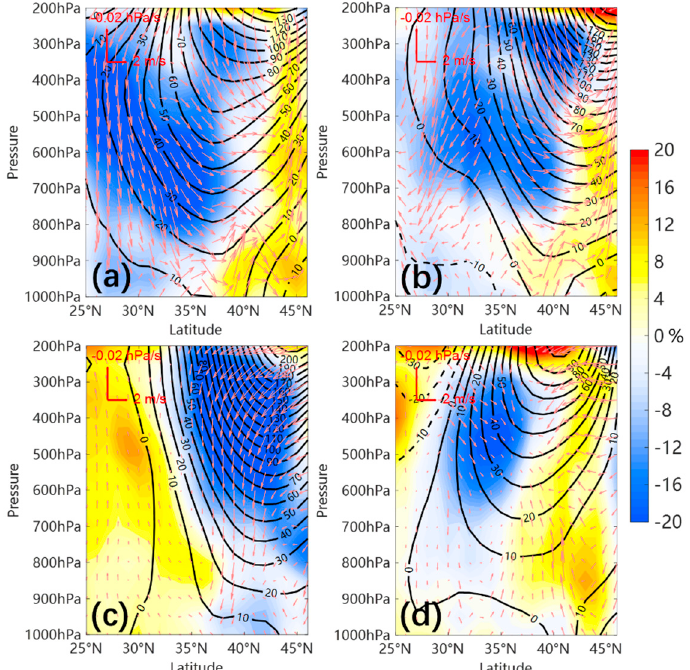
Figure 6. Zonally averaged geopotential height anomalies (contours; interval = 10; units: gpm), relative humidity anomalies (shading; units: %) and v-omega anomalies (vectors; units are labelled in the figure) over region B from the land surface to 200 hPa for ( a ) hot period 1, ( b ) hot period 2, ( c ) hot period 3 and ( d ) hot period 4.